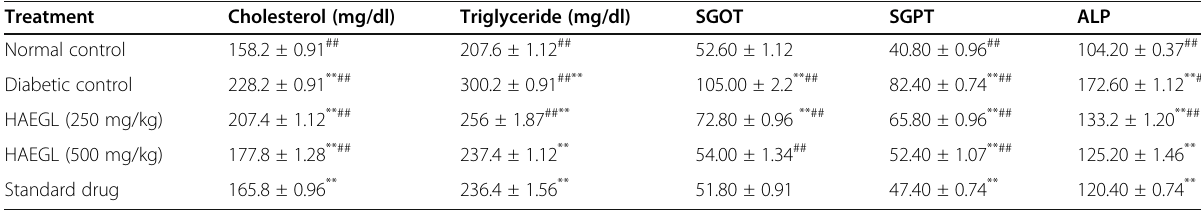
Table 6 The effect of HAEGL on biochemical parameters in streptozotocin-induced diabetic rats on the 15 th day of treatment